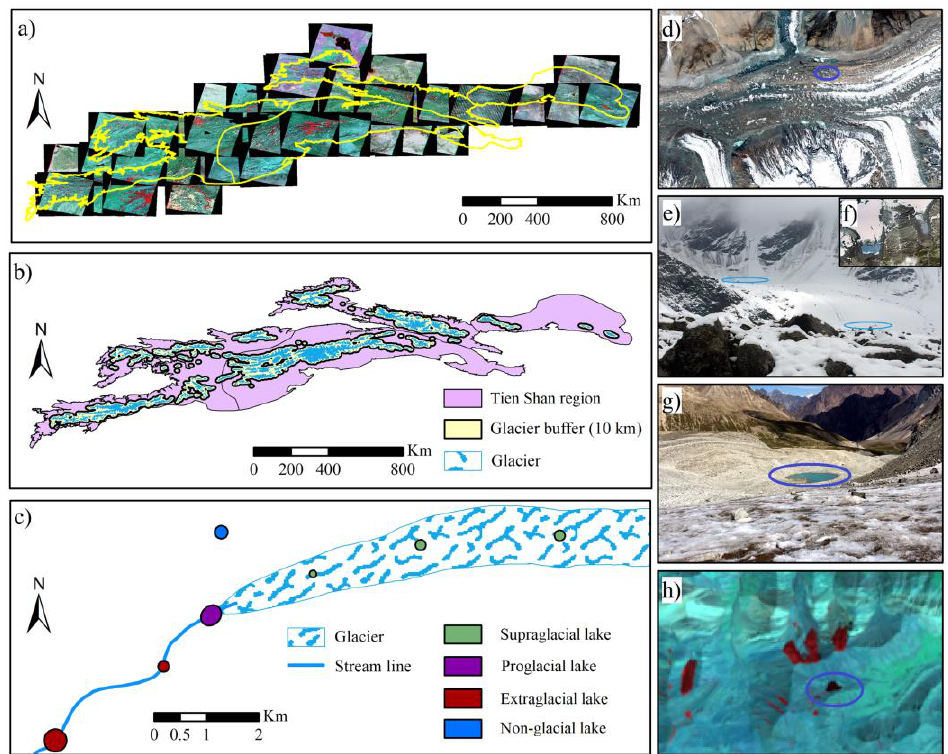
Figure 3. Diagram showing the classification of alpine lakes across the TS region ( a ); the available Landsat images used in the TS; ( b ) alpine lakes within a 10 km buffer zone of a glacier were extracted in the TS; ( c ) the position of different types of alpine lakes relative to the glaciers; ( d , e , f , g , h ) examples of supraglacial, proglacial, extraglacial and non-glacial lakes in the TS. Note: the bule framework means the different types of alpine lakes.